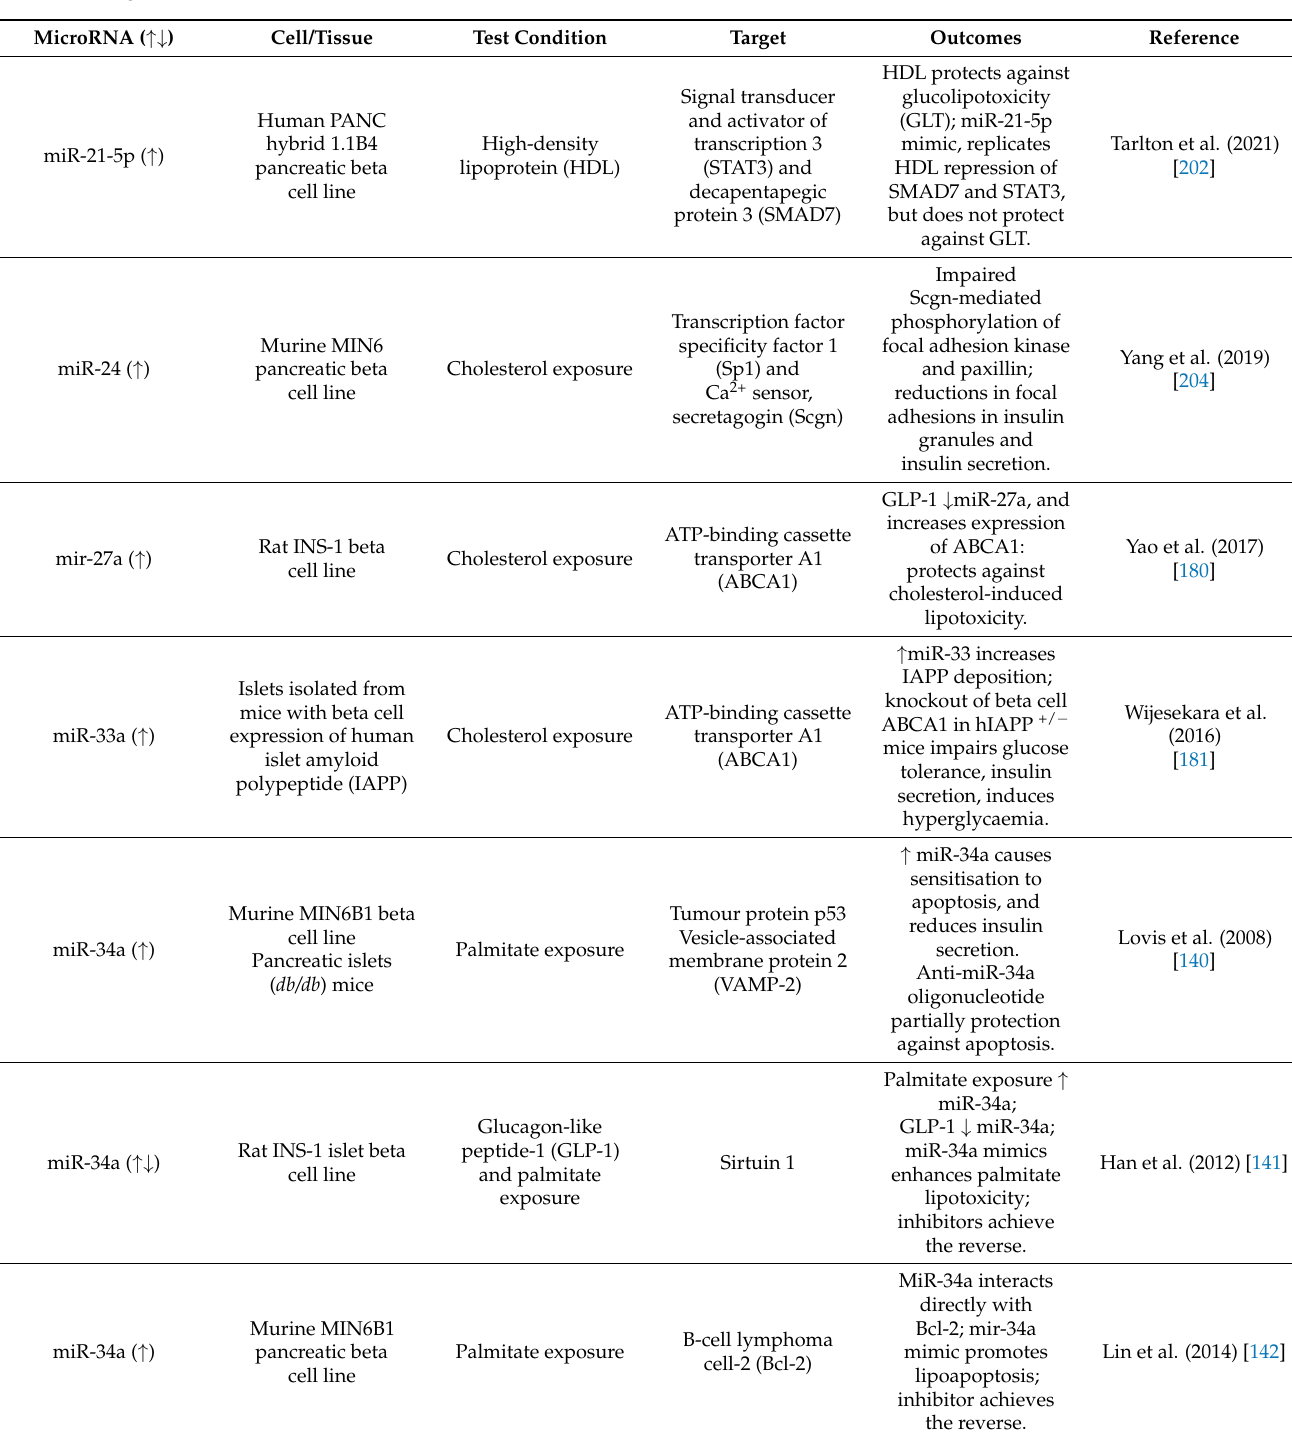
Table 1. MicroRNA sequences altered in response to metabolic challenges in islets and beta cells. Upregulation ( ↑ ) or downregulation ( ↓ ) is noted next to the